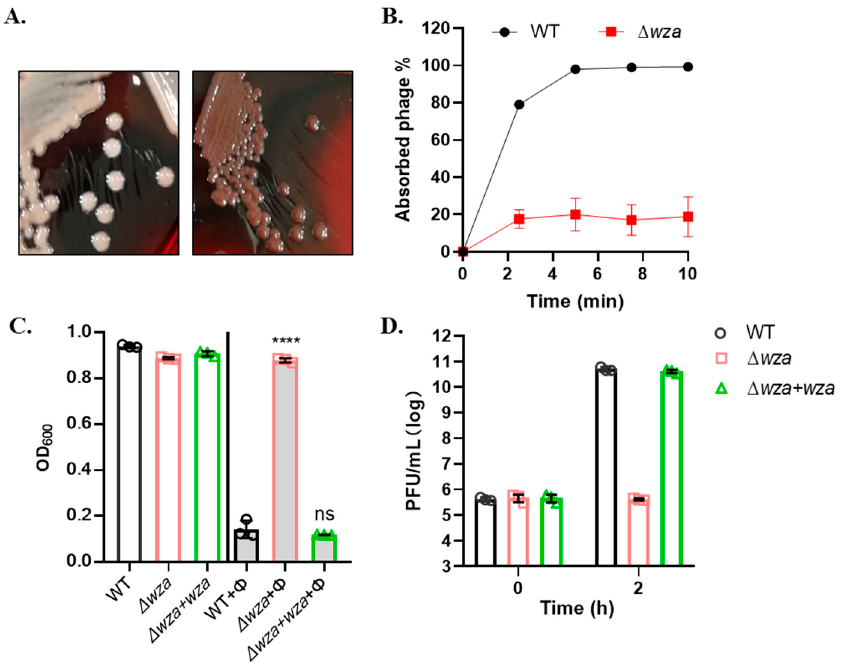
Figure 3. Phage SRD2021 infectivity on CRKP A1806 wildtype and CPS mutant strains. ( A ) Colony of wildtype ( left ) and ∆ wza ( right ) of CRKP on CRA plate. ( B ) Phage SRD2021 adsorption to wildtype and ∆ wza mutant, shown as residual PFU percentages. ( C ) The infectivity difference of Φ SRD2021 on wildtype, ∆ wza, and ∆ wza + wza mutant strains. The host bacteria were infected with Φ SRD2021 at MOI of 0.01. ( D ) Phage titers during Φ SRD2021 infection on wildtype, ∆ wza , and ∆ wza + wza . All data are the mean of three independent experiments. **** p < 0.0001 (2-way analysis of variance [ANOVA]); ns, no significance.